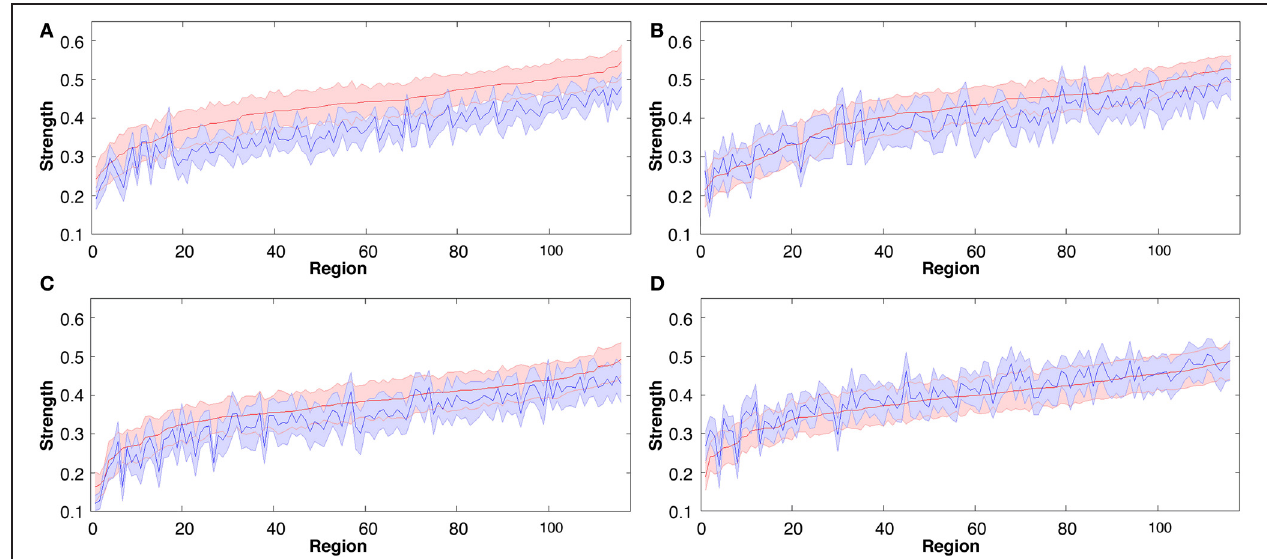
FIGURE 3 | Group mean connectivity strength for each of the 116 regions before and following all four tasks, rank ordered by mean regional strength measured in rest 2 (pre-task rest 1 data are shown in